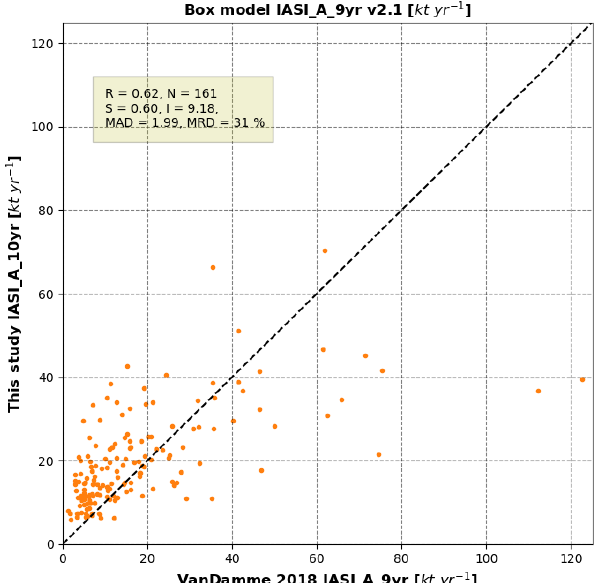
Figure E1. Comparison of emission estimates using this study’s method vs. those obtained using a box model approach of (Van Damme et al., 2018). The individual plots show the comparisons of this study, IASI-A (10-year) emission estimates, using a fixed σ of 15km and lifetime of 2.5h vs. the emission estimates obtained using a box model approach on the 9-year (2008–2016) ANNI-NH 3 -v2.1 IASI-A dataset. The later emission from Van Damme et al. (2018) have been adjusted to a lifetime of 2.5h and only locations characterized by a fit with a r > 0 . 3 with the approach used in this study have been kept. R indicates the correlation between the sets, N the number of locations, S and I the resulting slope and intercept of the RMA, MAD and